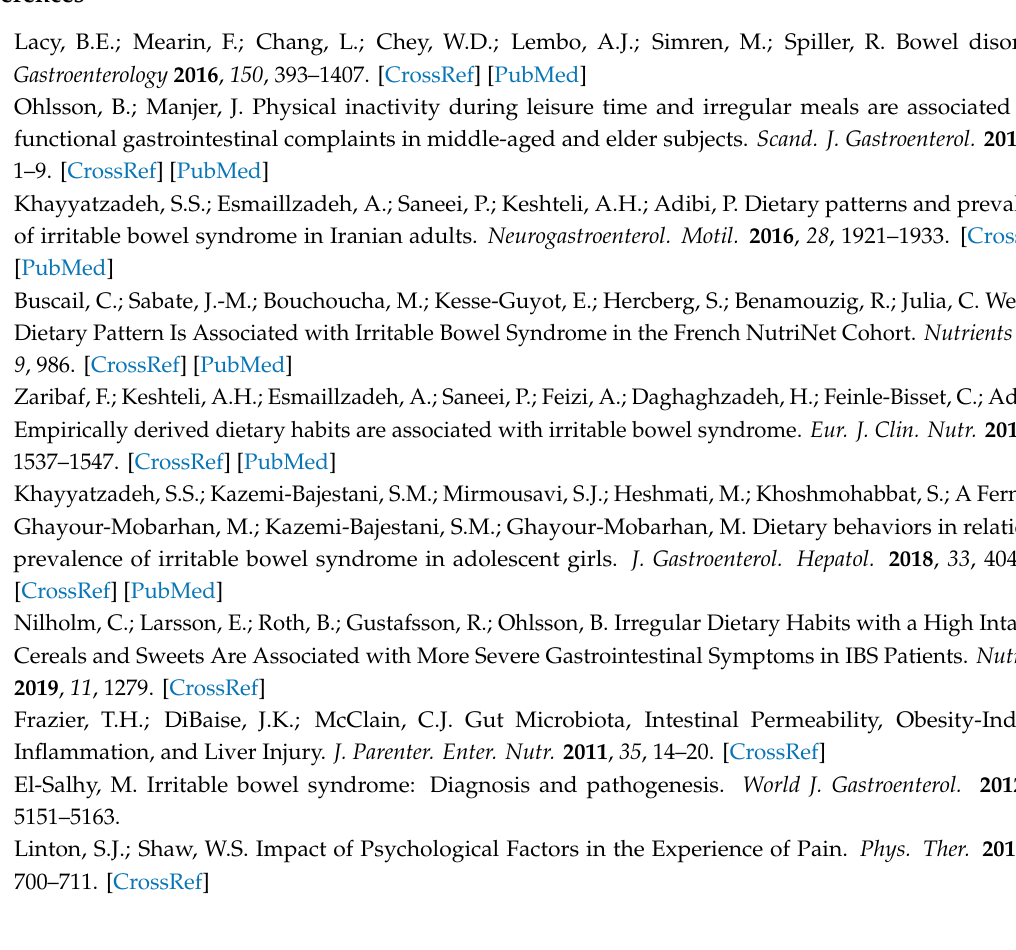
Figure S1: Flow chart over inclusion and exclusion criteria, Figure S2: CONSORT 2010 Flow Diagram, Table S1: Reasons for not being eligible for / declining study participation, Table S2: Recommendations of fruit intake according to a starch- and sucrose-reduced diet, Table S3: Recommendations of vegetable and legume intake according to a starch- and sucrose-reduced diet, Table S4: Concomitant diseases besides irritable bowel syndrome (IBS) and drugs used as regular